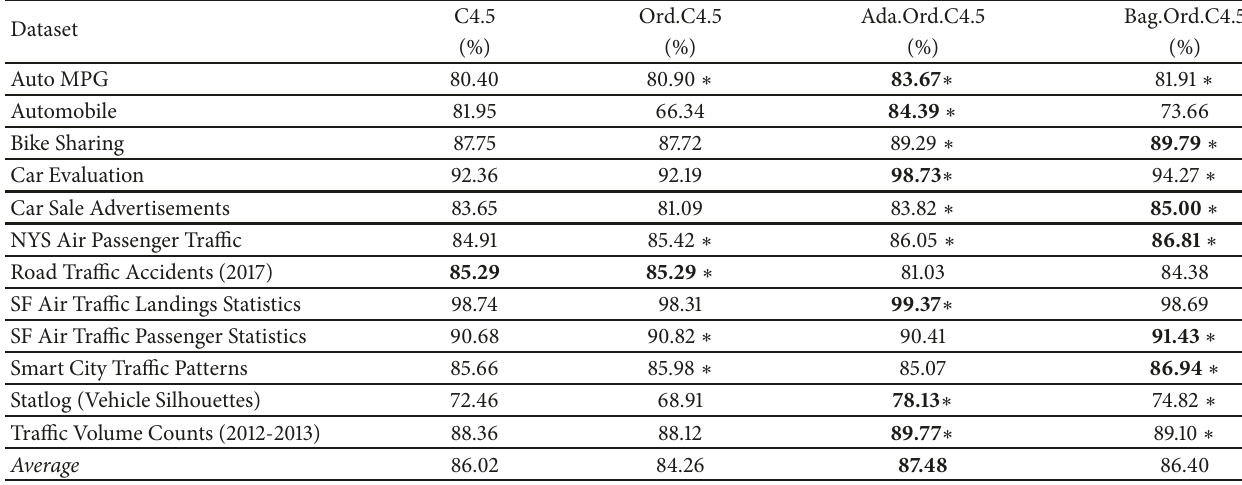
Table 3: The comparison of C4.5 based ordinal and ensemble learning methods in terms of classification accuracy. Dataset